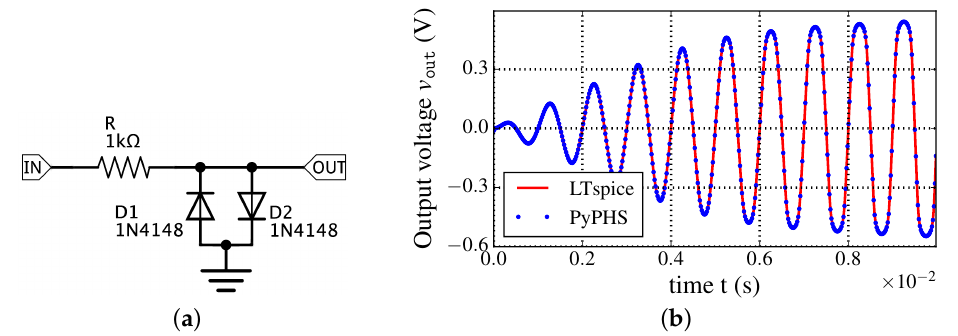
Figure 5. Simulation (Figure 5b) of a dissipative diode clipper (Figure 5a) at the sample rate f s = 96 kHz, with three Newton–Raphson iterations, for a 10 ms sinusoidal excitation at 1 kHz with linearly increasing amplitude between 0 V and 2 V. ( a ) Diode clipper schematic; ( b ) Simulation of the diode clipper of Figure